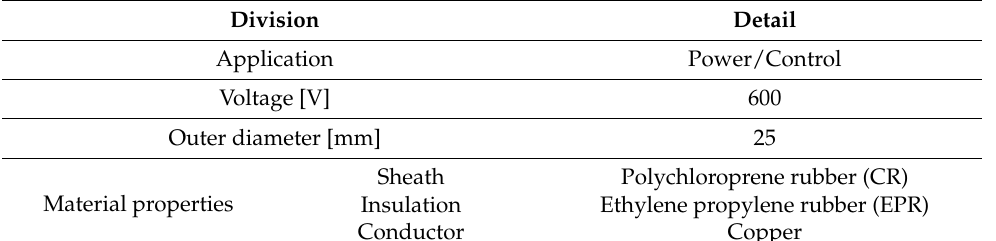
Table 1. Specification of experimental cable.